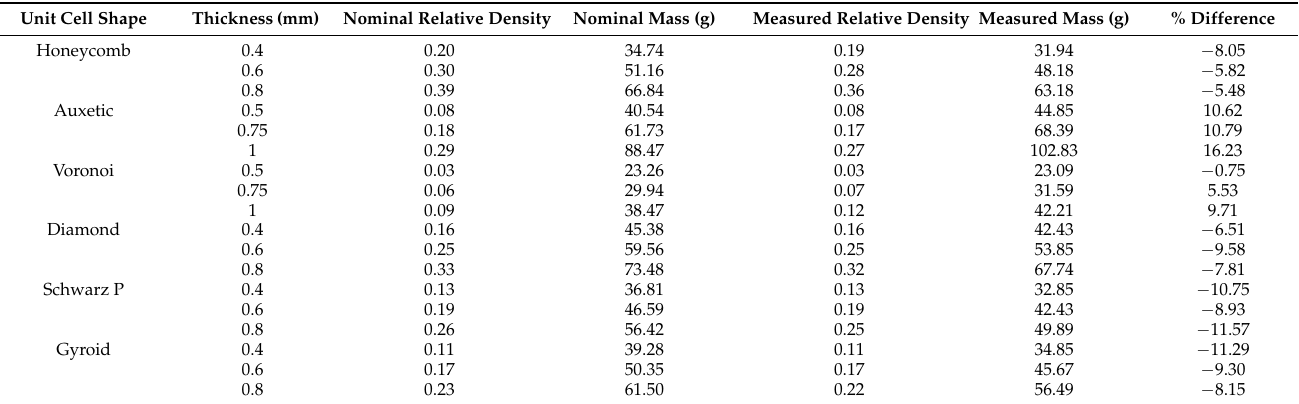
Table 2. Unit cell shapes and relative densities designed for the